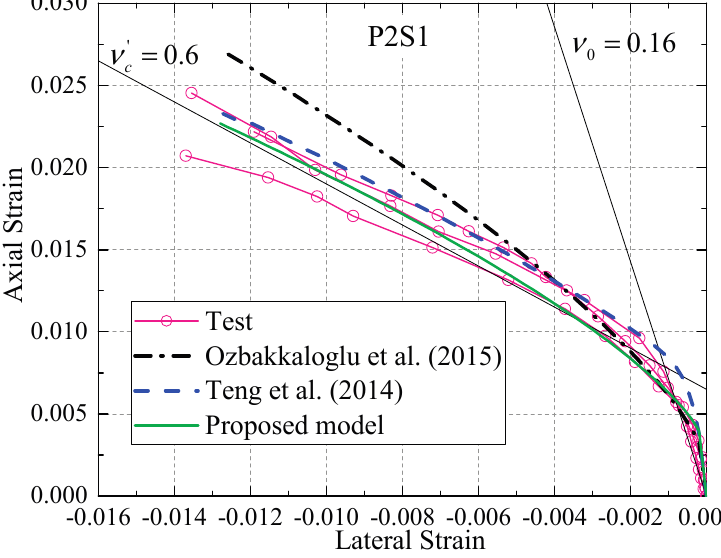
Figure 11. Comparison of model predictions with experimental lateral strain-to-axial strain